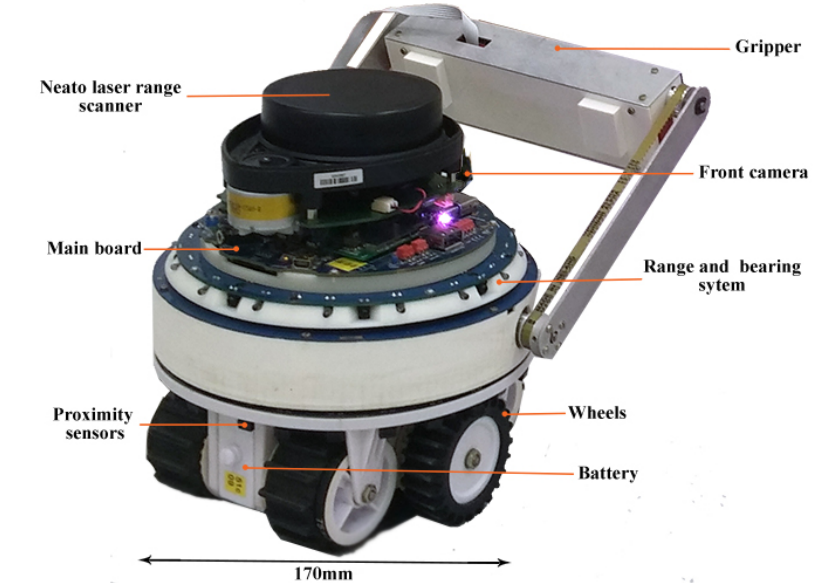
Figure 5. The marXbot, with five of its modules, that was used for our